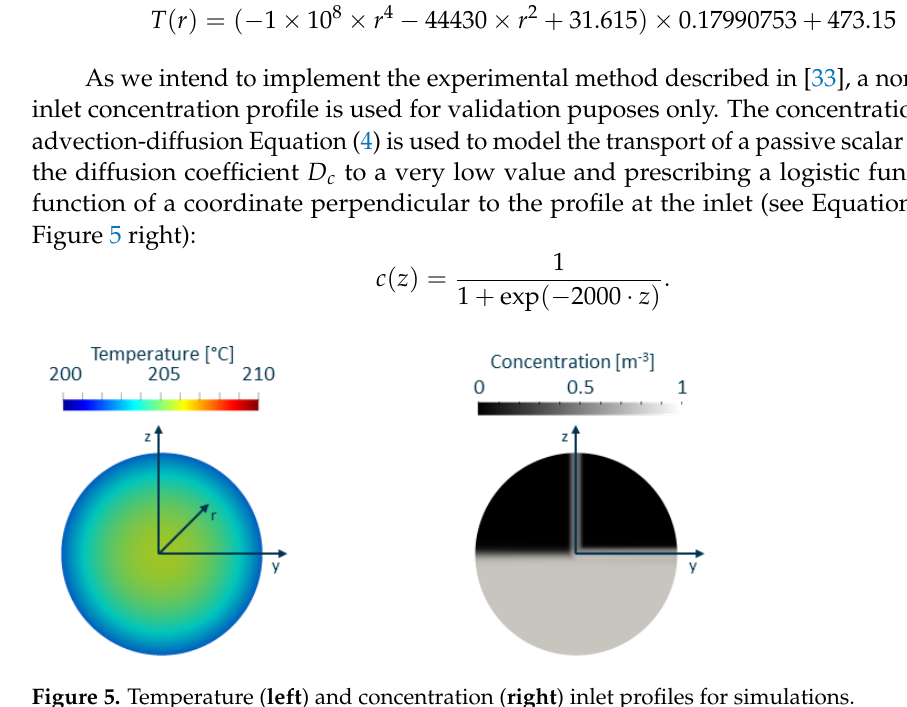
Figure 5. Temperature ( left ) and concentration ( right ) inlet profiles for